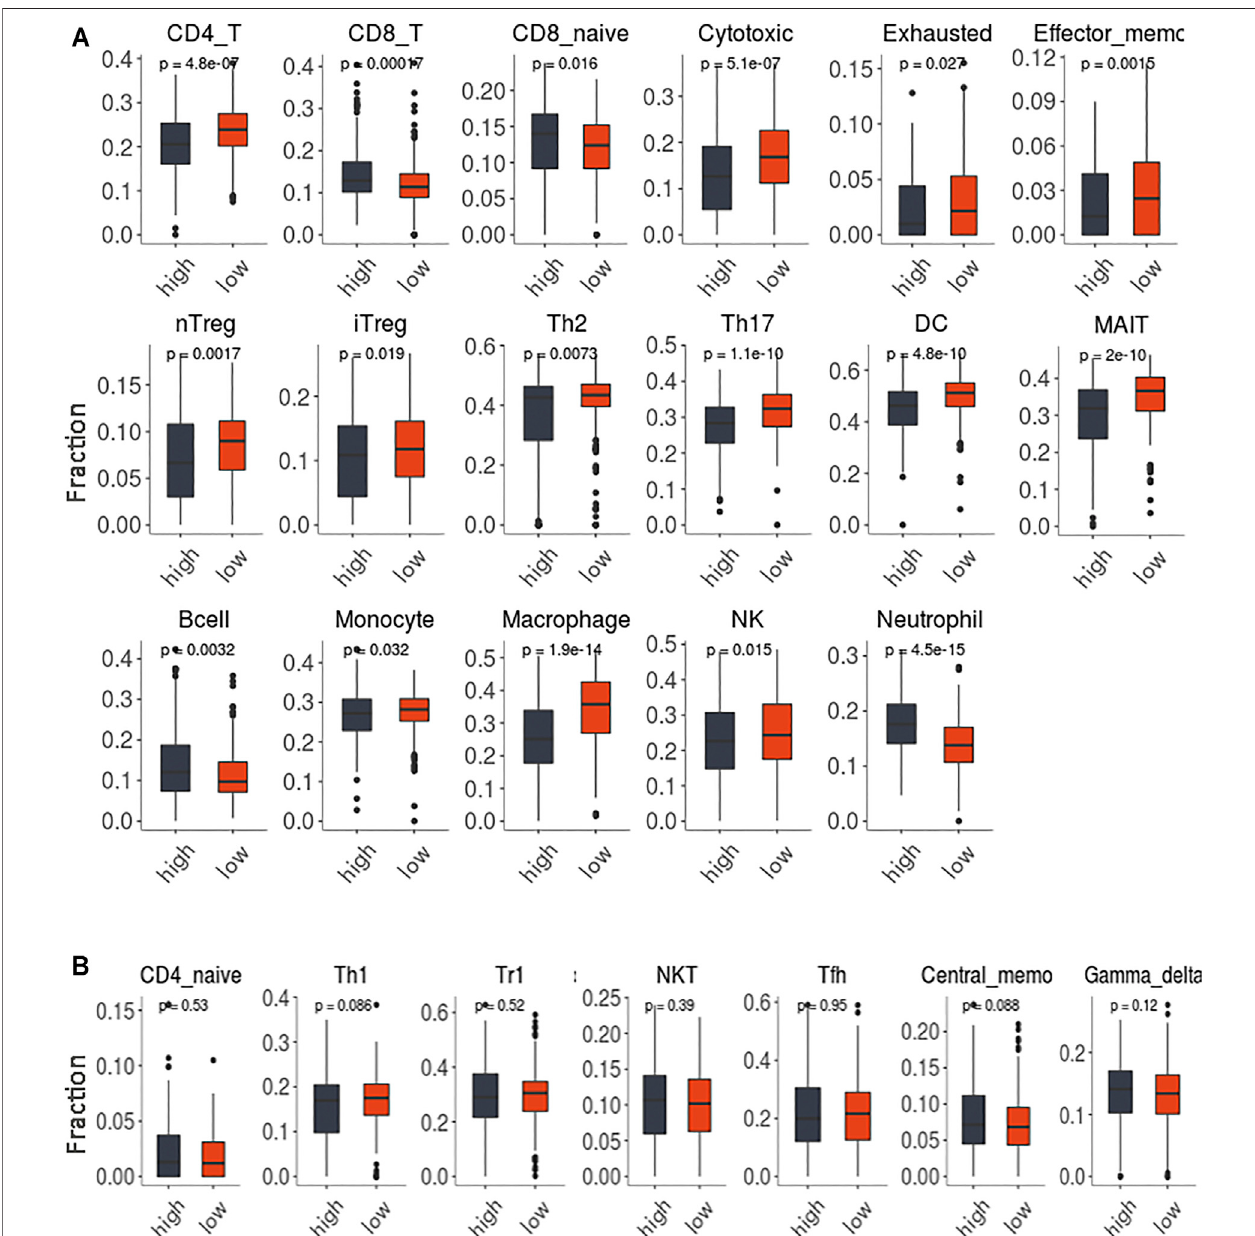
FIGURE 8 | The immune in fi ltration of 24 immune cells subsets in the tumor samples with high GSVA score and low scores. (A) . The comparisons with statistically signi fi cant difference. (B) . The comparisons without statistically signi fi cant difference.